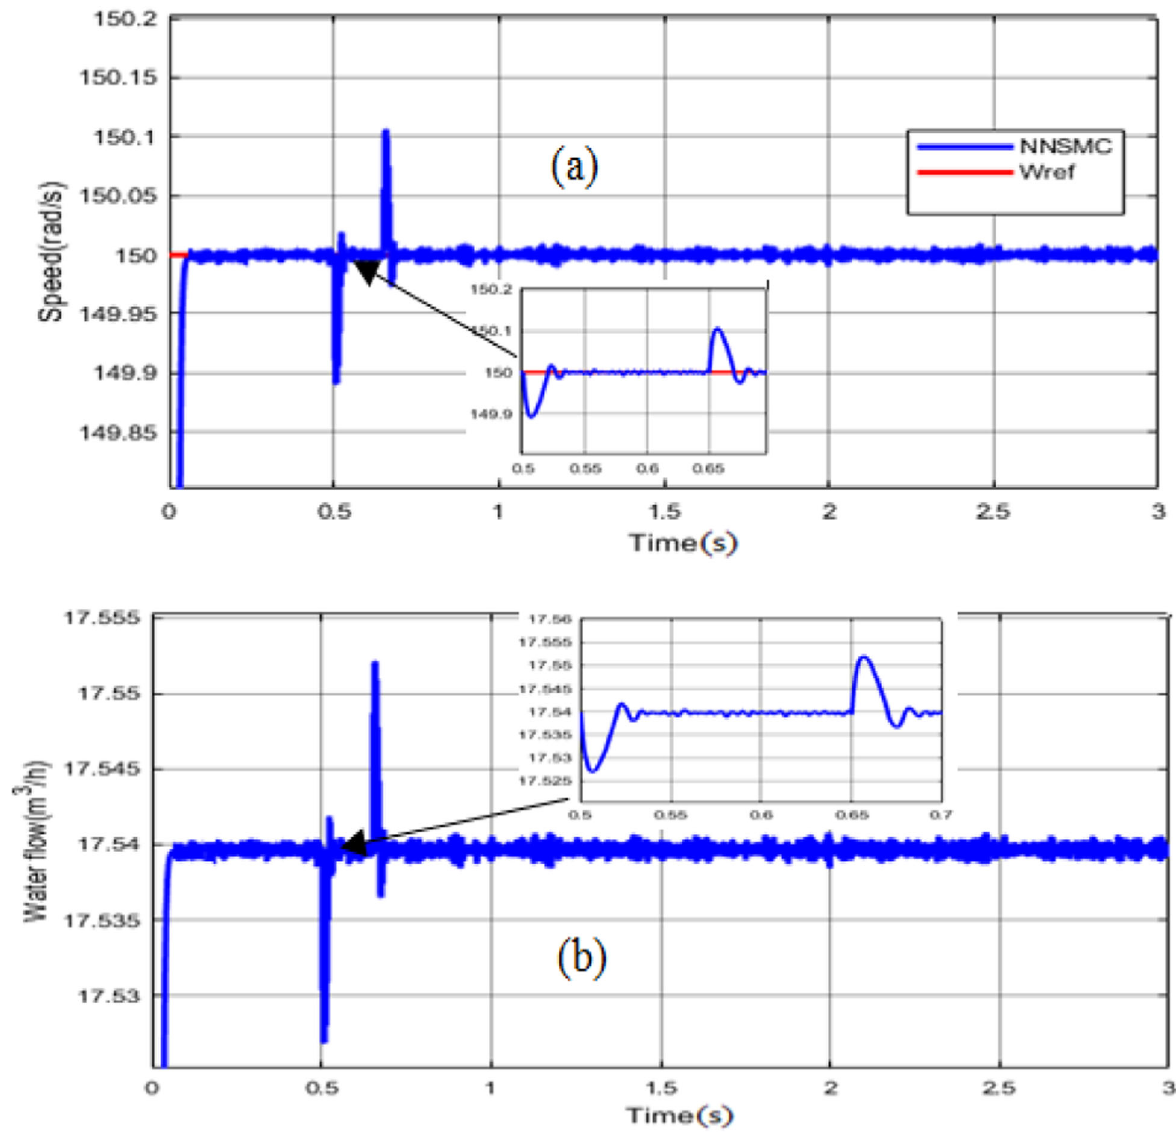
Fig. 20 Speed response under load torque